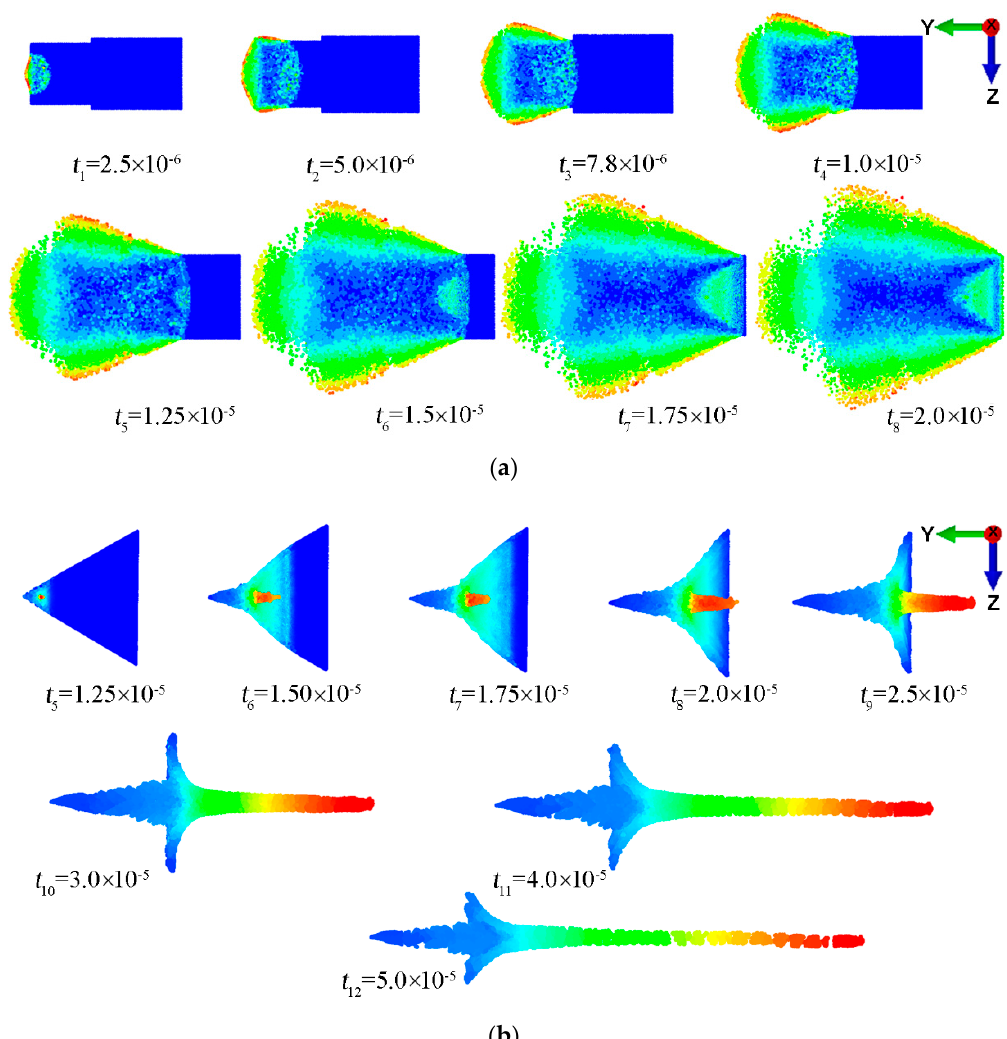
Figure 11. Stages of formation jet of the axial charge for individual time steps: ( a ) process of propagation of explosion detonation wave; ( b ) stages of the jet’s formation in the liner.